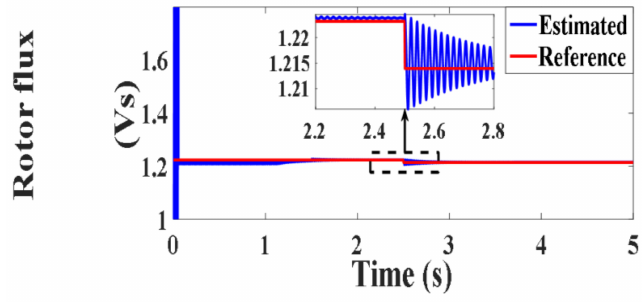
Figure 20. Rotor flux under SVOC